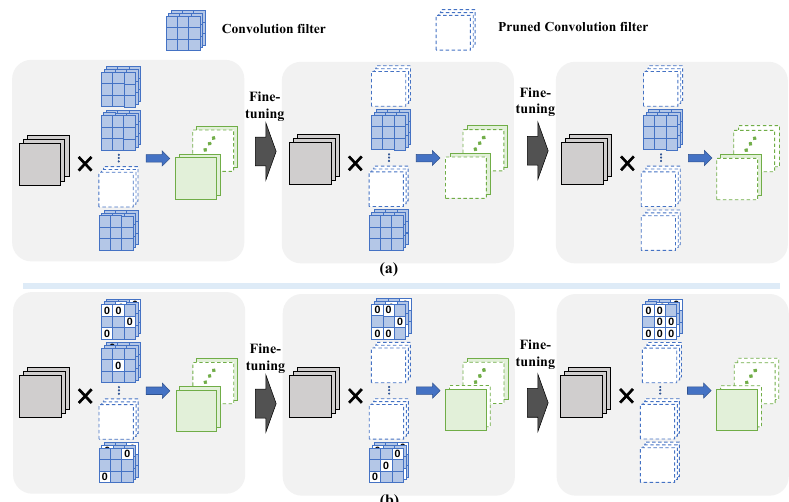
Figure 1. The abstract view of the conventional method ( a ) and the proposed method ( b ).